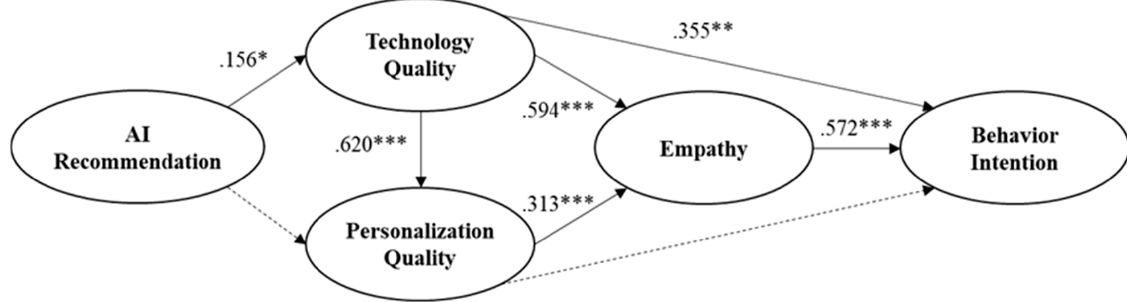
Figure 2. Structure model. (***, **, * indicate the remainder